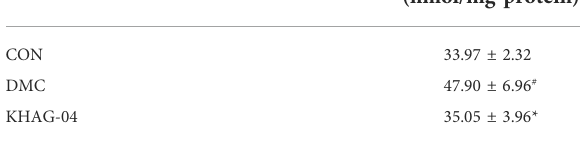
TABLE 2 GO level in the T2DM mice